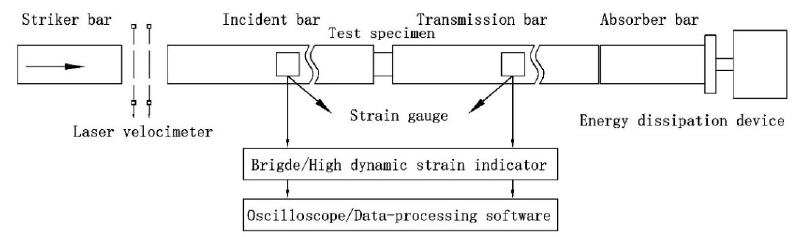
Figure 2. Photograph and schematic diagram of the split Hopkinson pressure bar (SHPB) test apparatus.